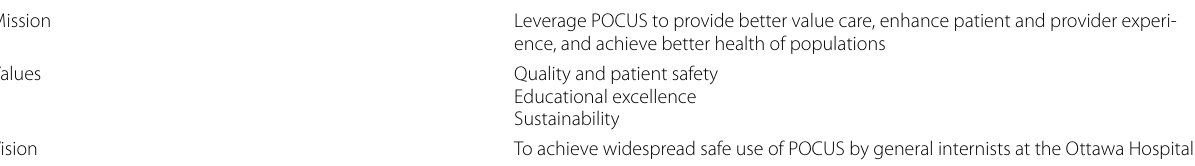
Table 1 Mission, values, and vision Mission